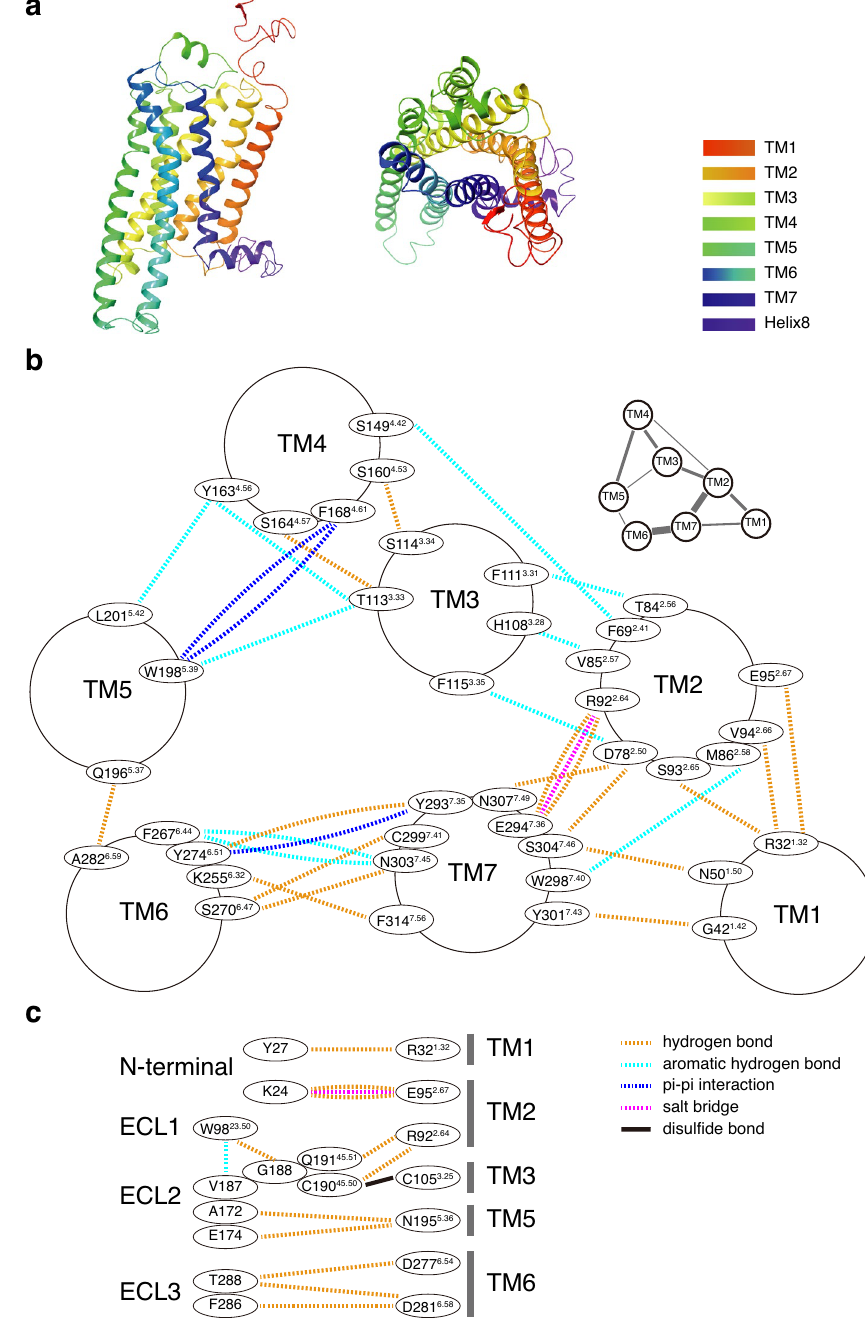
Figure 1. Homology modeling of TAAR9 predicts the intra-receptor interactions. ( a ) Homology modeling of mTAAR9 shows typical 7 transmembrane domains (colored according to residue position). Left: Side view. Right: Extracellular view. ( b ) Detailed inter-helical non-covalent interactions in TAAR9 from extracellular side view. Residue numbers were assigned following numbering scheme in GPCRdb 12 . Dotted lines represent presence of inter-helical interactions. Those interactions are mainly composed of hydrogen bonds (deep yellow) and aromatic-hydrogen bonds (cyan), with a few salt bridges (magenta) and pi-pi interactions (blue). An overview of inter-helical interactions network is shown in upper right, with thicker lines indicating stronger interactions. ( c ) Interactions between TM and N-terminal, TM and ECL, inter-ECL. Besides those interactions described in between TMs, disulfide bond (black lines) is observed between C190 45.50 and C105 3.25 . Only residues in TM1, 2, 3, 5, 6 show interaction with extracellular